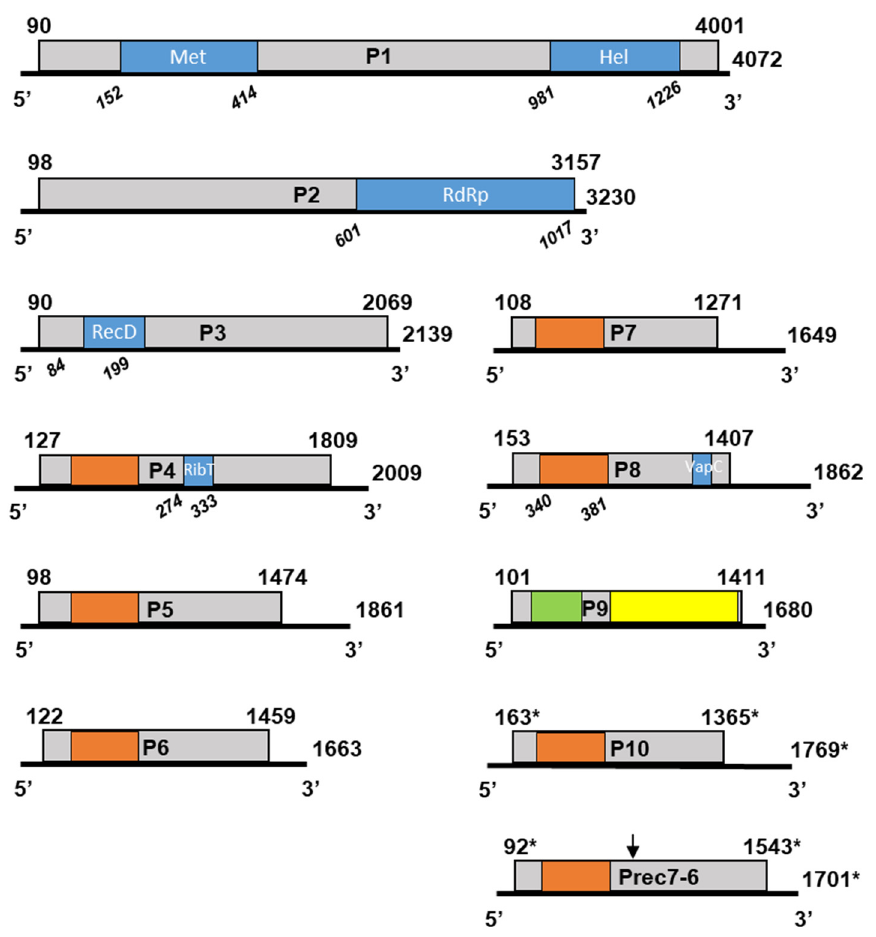
Figure 3. Schematic genome organization of GaJV-1. Boxes represent the open reading frames (ORF) encoded on each genomic RNA. Nucleotide positions of ORFs are indicated above, while molecule length is indicated on the right. Conserved protein motifs are indicated by blue boxes, with amino acid positions are indicated in italic below. The motifs identified are Met: viral methyl-transferase family (cl03298), Hel: viral helicase 1 family (pfam01443), RdRp: RNA-dependent RNA polymerase 2 family (pfam00978), RecD: RecD family helicase (cl37724), RibT: nucleoside ribosyltransferase domain (pfam15891.8), VapC: virulence-associated protein C domain (COG1487). A ca. 130 aa region shared between the P4, P5, P6, P7, P8, P10 and Rec7-6 proteins is indicated by orange boxes. A ca. 100 aa region shared between GaJV-2 P3 and the P9 of Carya jiviviruses 1 and 2 is indicated in green, while a ca. 250 aa region shared between the P9 of Carya jiviviruses 1 and 2 is indicated in yellow. Nucleotide positions for RNA10 and RNArec7-6 are marked by an asterisk to indicate that 5’ and 3’ ends have not been determined.